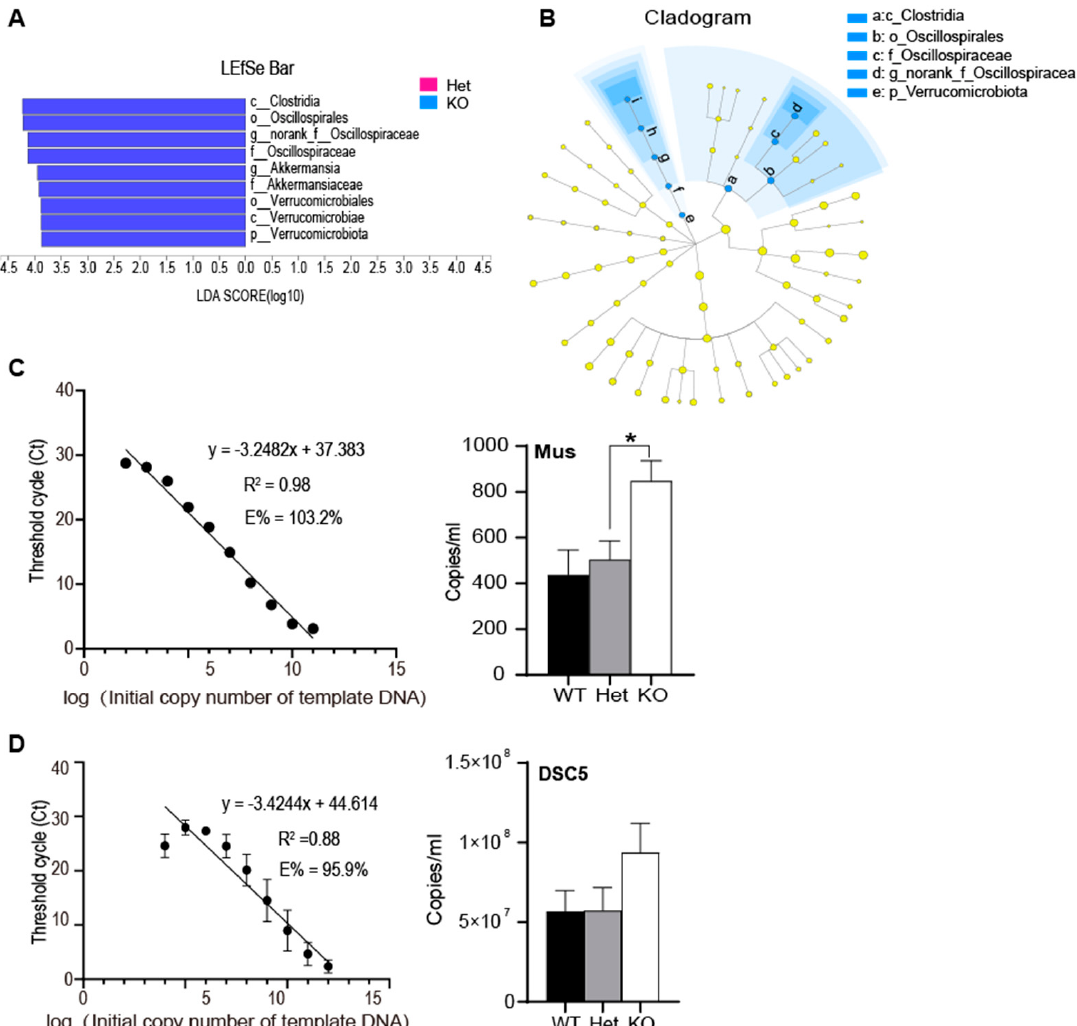
Figure 4. LEfSe analysis of significant differences in species between groups. ( A ) LDA value distribution histogram, the length of the histogram represents the impact of different species (LDA Score); ( B ) LEfSe multi-level species tree diagram: species with significant differences between groups. Nodes with blue indicate microbial groups that are significantly enriched in the corresponding group and have a significant impact on the differences between groups (LDA > 3); light yellow nodes indicate that there is no significant difference in different groups. From the inside to the outside, it is from the phylum to the genus level. LefSe, Linear discriminant analysis effect size. ( C , D ) Standard curve ( left ) and copy values of gene fragments in different groups ( right ). t -test, * p < 0.05, error bars represent SEM. WT, Wild Type; KO, Knockout; Het, Heterozygote.